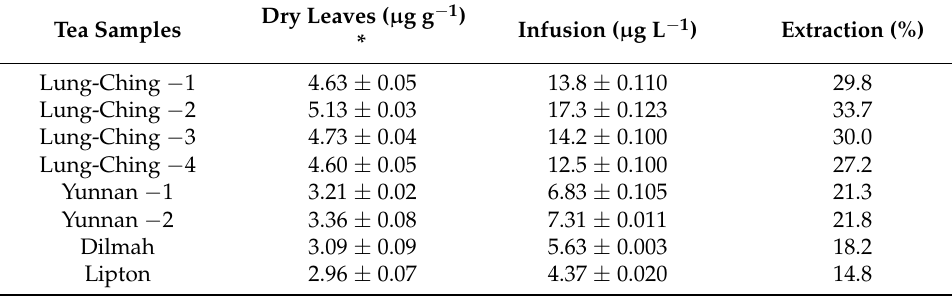
Table 1. Selenium in green tea samples and their